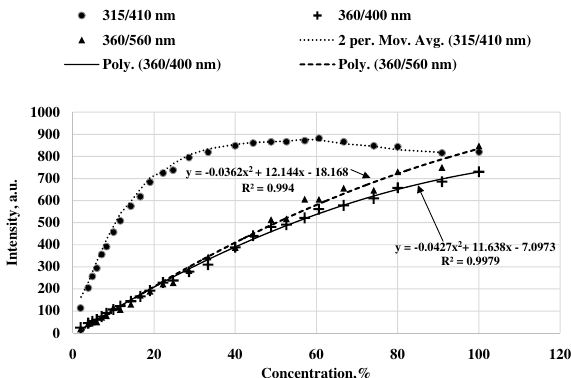
Fig. 5. Fluorescence intensity dependences in a Pt's urine (protein-uria) on the VFS residual concentration at the di®er- ent parameters of excitation and emission registration.